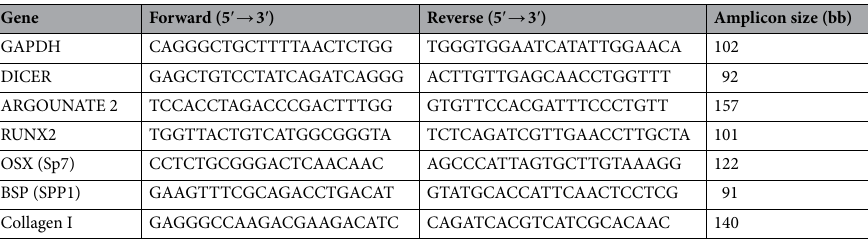
Dicer and Argonaute 2 gene expression knock‑down monitoring. Dicer mRNA levels in Dicer knock-down (DicerKD) and wild type (WT) hMSCs, and Argonaute 2 mRNA levels in Argonaute2 knock-down (AGO2KD) and WT hMSCs were assessed using RT-qPCR at day 1, 7 and 14 in osteogenic medium (αMEM growth medium containing 100 µg/ml ascorbic acid, 10 mM β-glycerophosphate, and 10 mM dexamethasone) (Primers are listed in Table 3). Dicer and Argonaute 2 protein levels were tested in all 3 cell types at day 1 using immunoblotting (Abcam, ab186733, 1/1000 for Argonaute 2; ab14601, 1/250 for Dicer; and Sigma, T5168, 1/2000 for Tubulin). Proliferation assays. In order to assess the effect of miRNAs on hMSC proliferation, WT, DicerKD and AGO2KD hMSCs were seeded in four 96-well plates (Day 0, each plate containing 0.01 × 10 4 cells/well, 8 wells